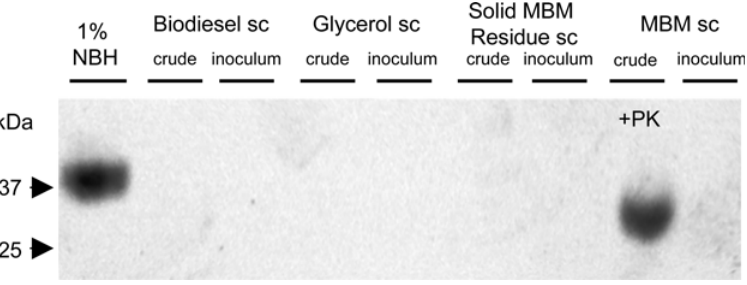
Figure 2. Western blot analysis of reaction products from MBM spiked with 5% scrapie brain. We performed alkaline methanolysis on scrapie brain spiked MBM as described under Methods and analyzed the reaction products as well as the inoculation samples by Western blot using monoclonal (mAb) 3F4. Results show no PrP detected in any of the 3 phases produced by the reaction (crude), nor in the inoculum we subsequently prepared by diluting each phase to 25 m g of total brain equivalent protein into 50 m l of 320 mM sucrose. After proteinase K digestion PrP sc was clearly detected in MBM spiked with infected brain but not subjected to the reaction (MBM sc, crude + PK). 1% NBH served as a control, displaying a slightly higher molecular weight, since it was not proteinase K digested.